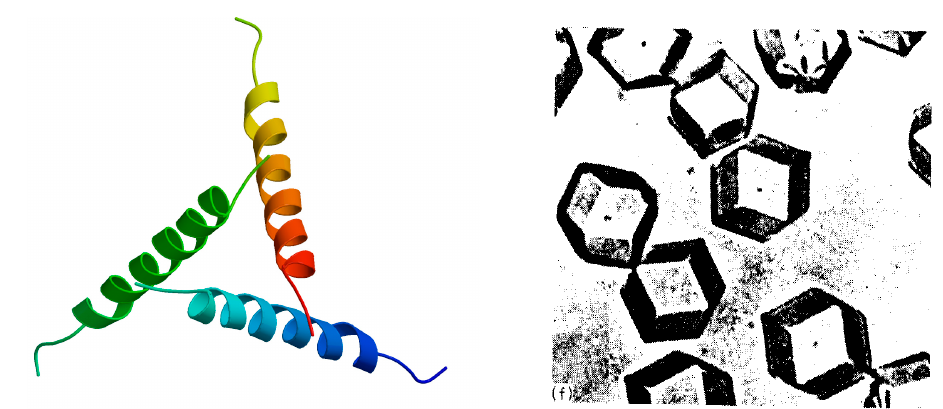
Figure 2. The structure of the glucagon trimer was defined by X ‐ ray diffraction of cubic glucagon crystals [15].